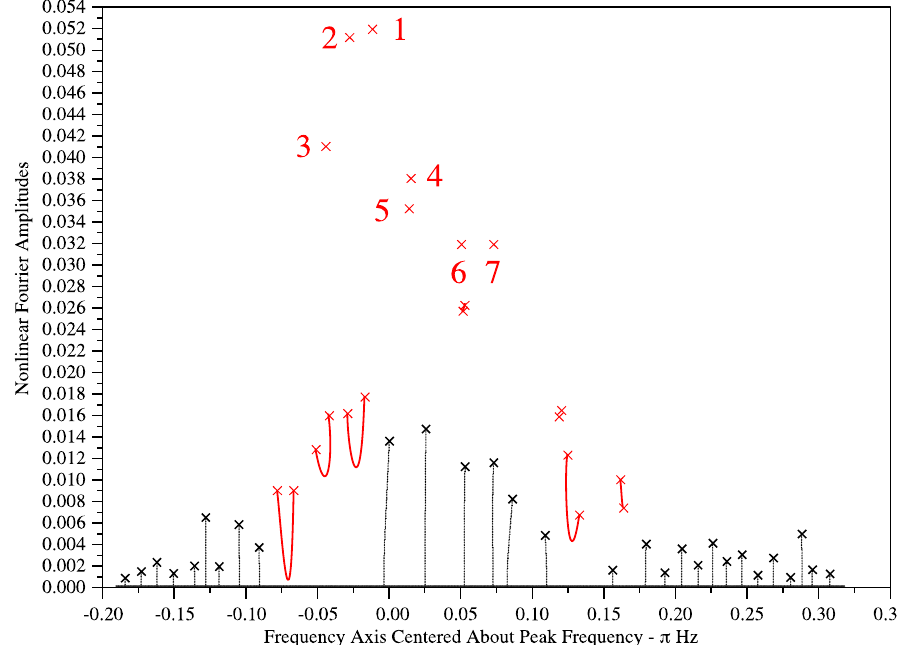
Figure 27. The NLFA spectrum for the time series in Figure 26. Sine wave and Stokes wave components are shown by black crosses connected to the frequency axis by a “spine.” See discussion with regard to Figure 1. Breathers are colored red and consist of two points of simple spectrum ( red crosses) connected by a spine (a red line). When the two points of simple spectrum are too close, the spine is not visible and only a single cross is seen. This happens for the largest breathers near the peak of the spectrum. The numbers near the largest breathers coincide with those in the measured time series in Figure 26. This emphasizes the one to one nature of the nonlinear spectral components of breathers (this figure) and the breathers themselves (Figure 26) in the time domain.